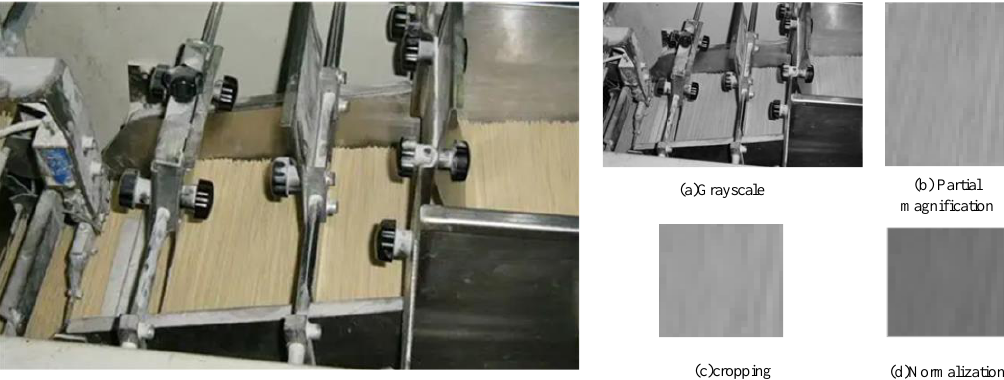
Figure 7. Preprocessing of the original image.